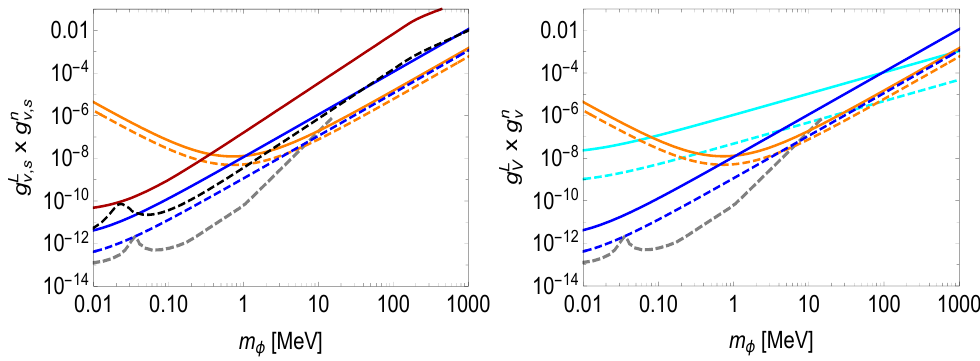
Figure 3 . Left plot: comparison between the sensitivity reached by electronic and muonic atomic spectroscopy considering a new dark force mediated by either a scalar or a vector new particle. We assume g e = g µ and g p = g n = g N . The orange line represents the bound from µ D spec- troscopy. The blue curve represents the updated bound from the latest H Lamb Shift measure- ment [20](considering also the muonic hydrogen measurement for the proton charge radius), while in the brown curve the proton charge radius is taken from e-scattering experiments [6]. Dashed lines correspond to future improvements. The grey dashed line represents the projection for the Yb IS measurement as proposed in [13], while the dashed black is the projection for the IS He 4 bound as explained in [6]. Right plot: this plot applies only to the case where the new force is mediated by a vector new particle, since we also include (cyan lines) the bounds coming from 2 s HFS in regular hydrogen (see table 2).